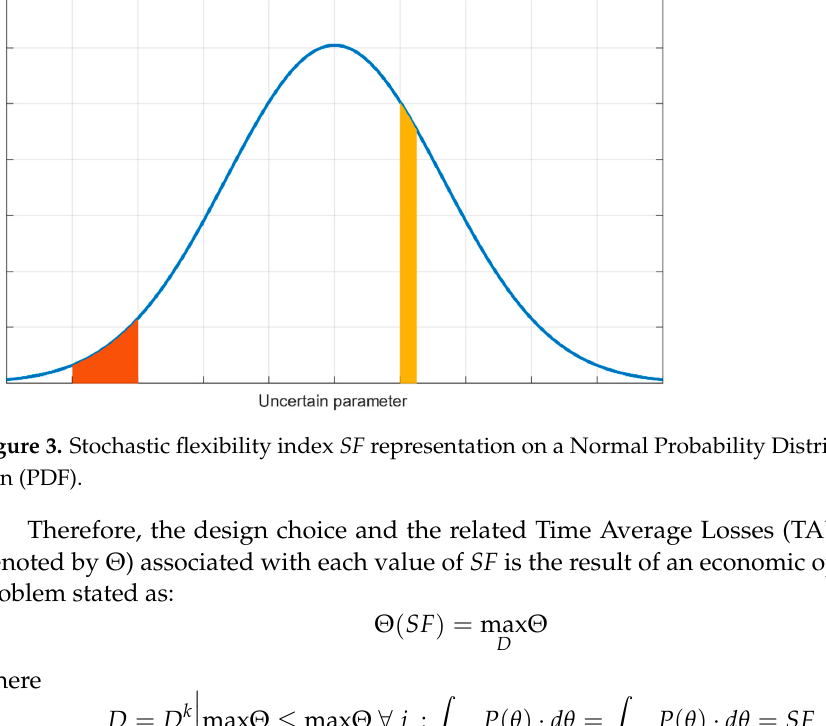
Figure 2. Flexibility representation on the uncertain domain.